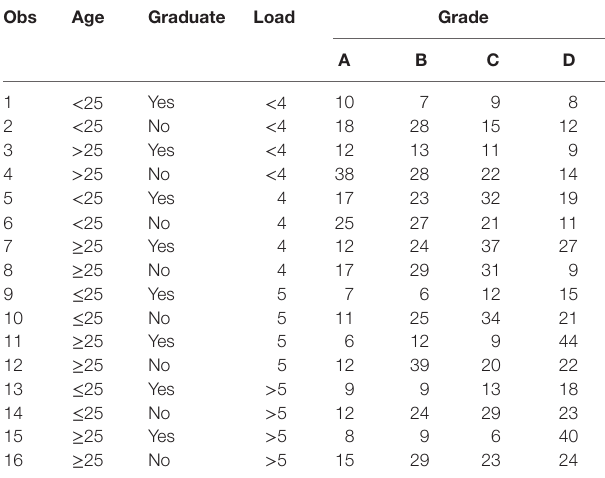
TABLe 8 | employee survey